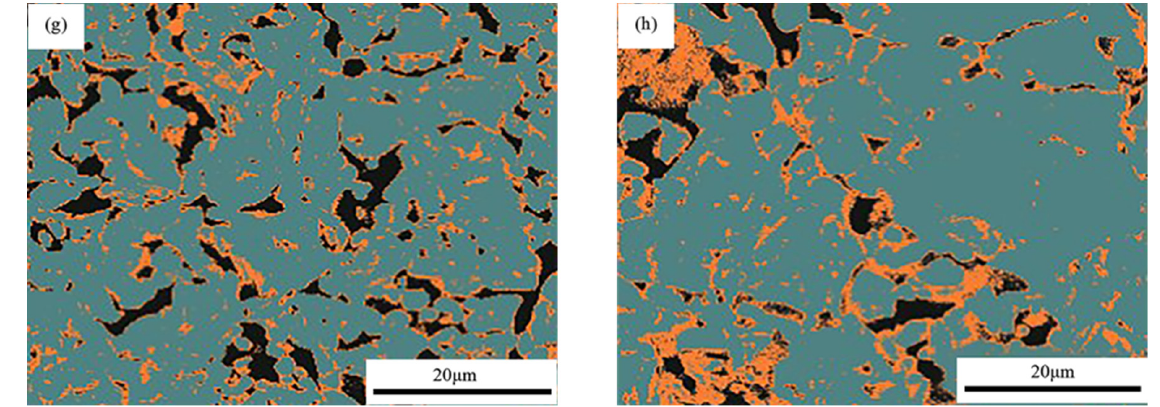
Figure 11. The effect of bentonite on the fired pellet compressive strength with ( a ) Kept the starch and bent. at 6.6 kg/t [114]. ( b ) The binder dose was 0.5 wt%. MCB = 0.333 wt% MHA + 0.167 wt% Ca-bent. [52]. ( c ) Kept 0.75% bent. ( d ) Alcotac ® CS: Modified anionic polyacrylamide blend [115]. SEM images of fired pellets with ( e , f ) 2% bent. [116]. ( g ) 0.6wt% bent + 0.02wt% Alcotac. Porosity = 25%. ( h ) 1.8 wt% bent. Porosity = 21% [115].